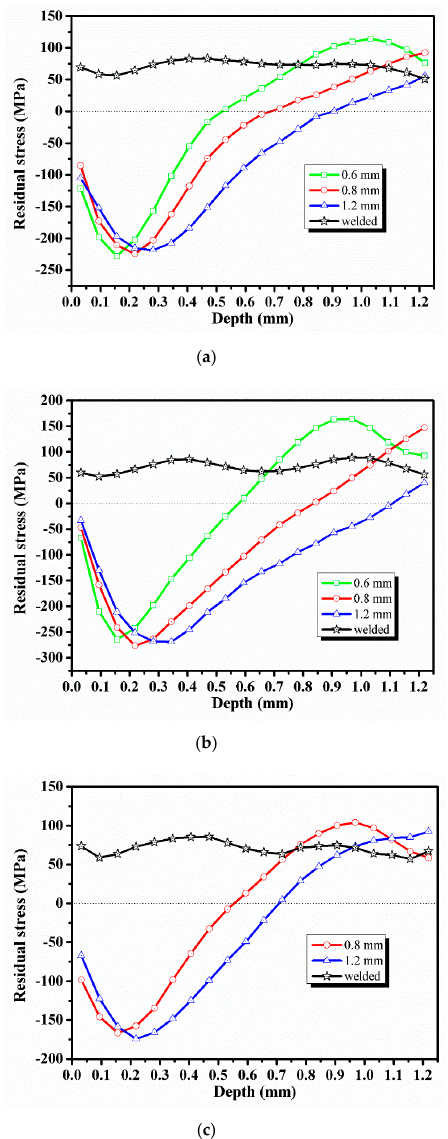
Figure 8. Effect of shot peening on the redistribution of internal residual stress: ( a ) shot peening with glass, ( b ) shot peening with steel, and ( c ) shot peening with corundum.